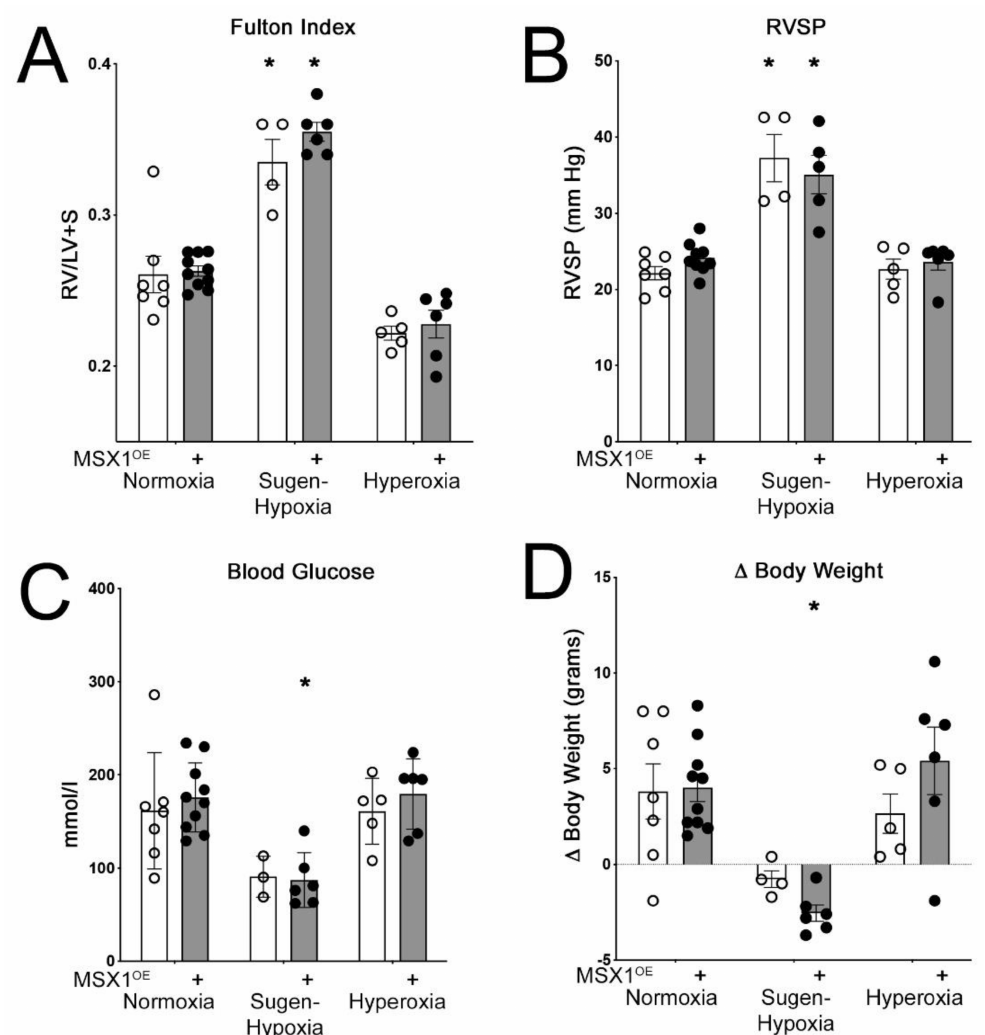
Figure 3. Hemodynamic parameters. ( A , B ) Fulton index and RVSP increases following sugen hypoxia treatment in control and MSX1 OE mice. ( C ) Blood glucose levels decrease in MSX1 OE mice following sugen hypoxia treatment compared to mice under normoxic conditions. ( D ) Body weight decreases in MSX1 OE mice following sugen hypoxia treatment compared to mice under normoxic conditions. (* p < 0.05—Comparing control and Msx1 OE mice from normoxia group with sugen-hypoxia group, respectively). (Open circles control mice and black circles MSX1 OE